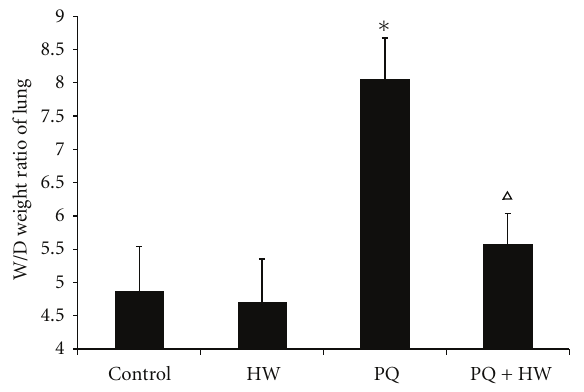
Figure 2: E ff ect of hydrogen water on lung edema. The lung wet/dry weight ratio of rats in PQ group was significantly higher than that of the control group ( P < . 01). Compared to the PQ group, wet/dry weight ratio of rats in PQ + HW group was significantly decreased ( ∗ P < . 01 compared to control; (cid:2) P < . 01 compared to PQ group).